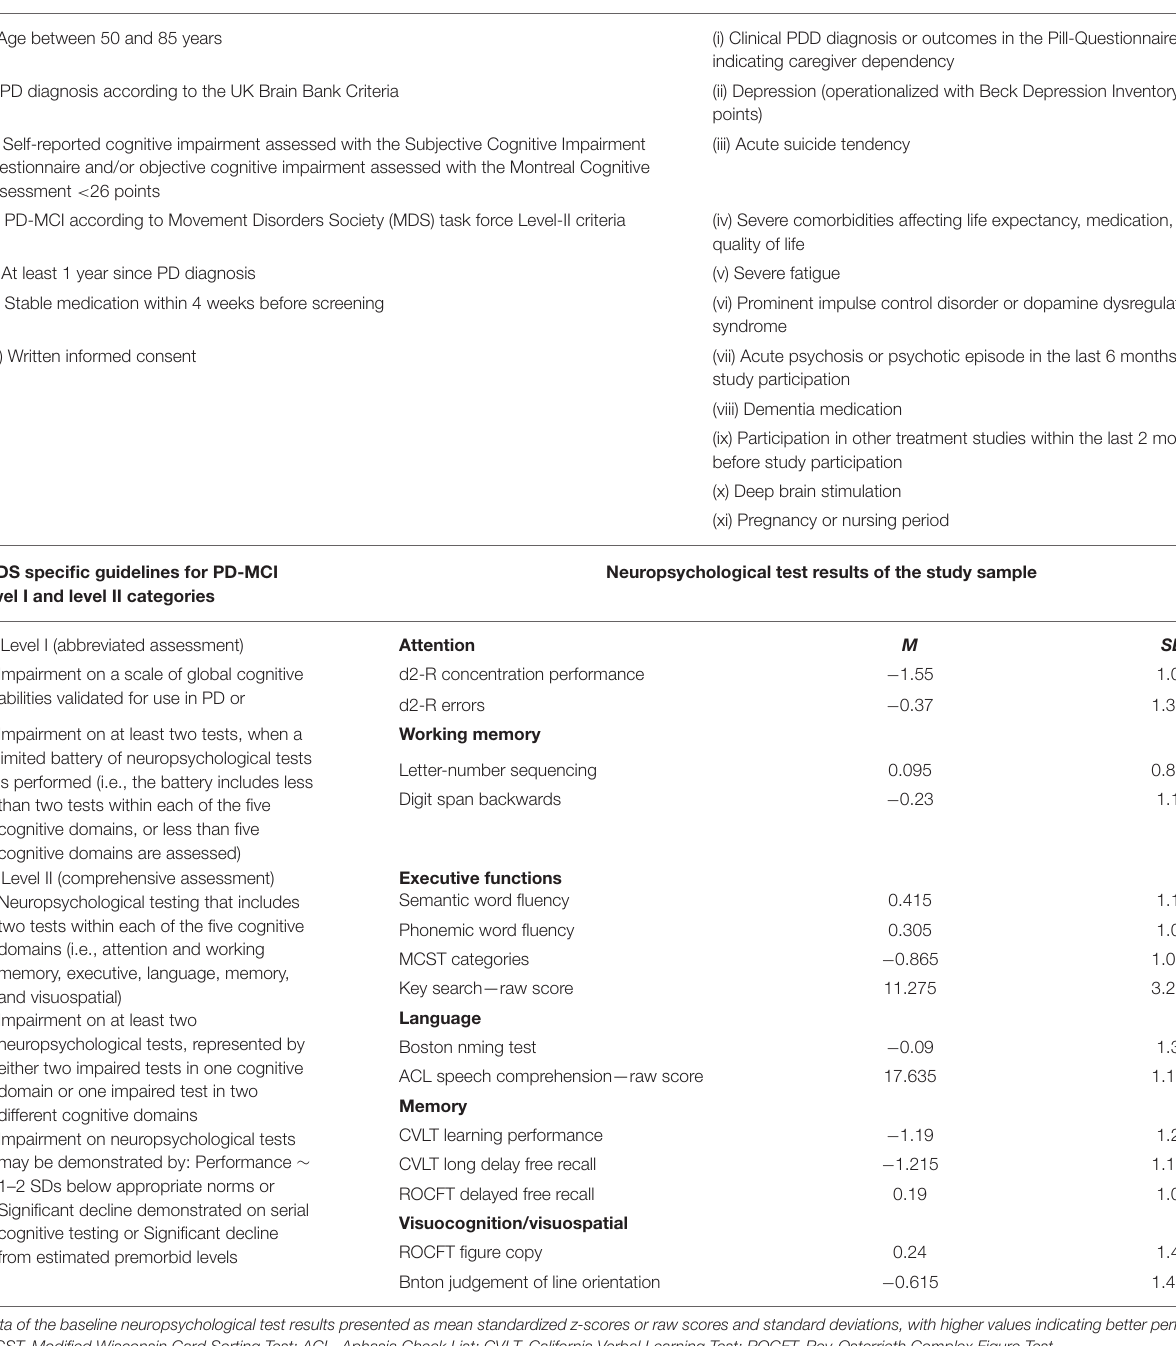
TABLE 1 | Inclusion and exclusion criteria, MDS specific guidelines for PD-MCI level I and level II categories and neuropsychological test results of the study sample. Inclusion